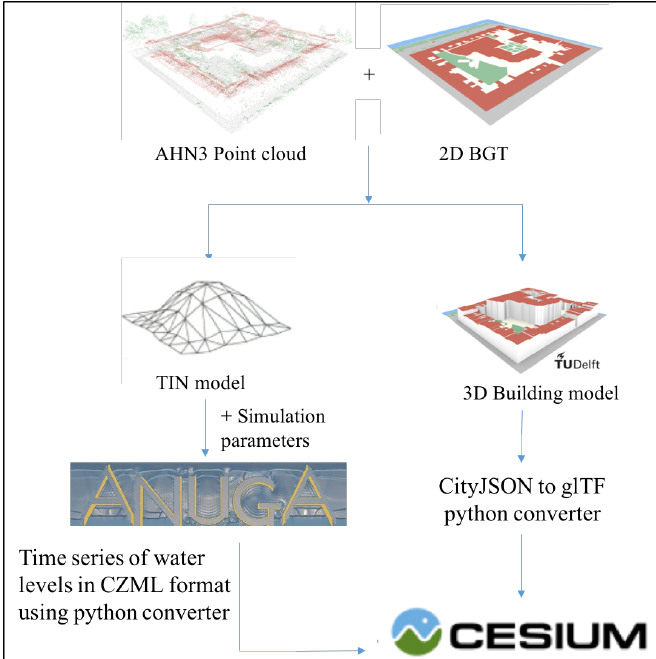
Figure 1: Proposed framework for visualizing floods using Ce- sium 3D